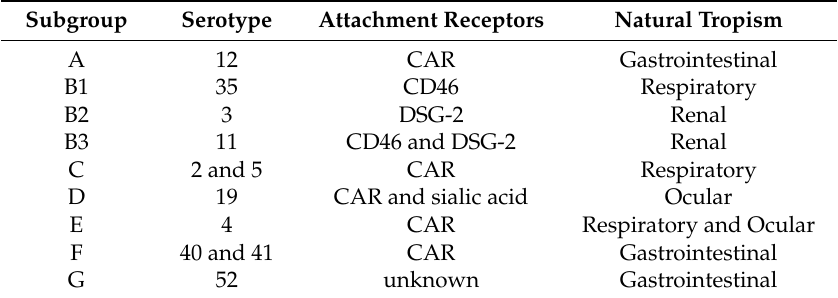
Table 1. Natural tropism of adenoviral